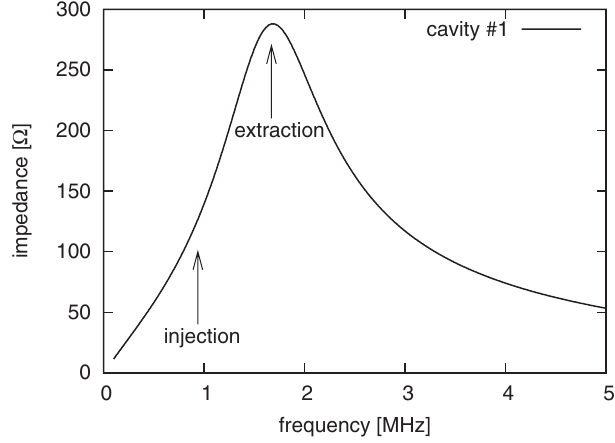
FIG. 3. Typical rf cavity impedance (absolute value, cavity #1).